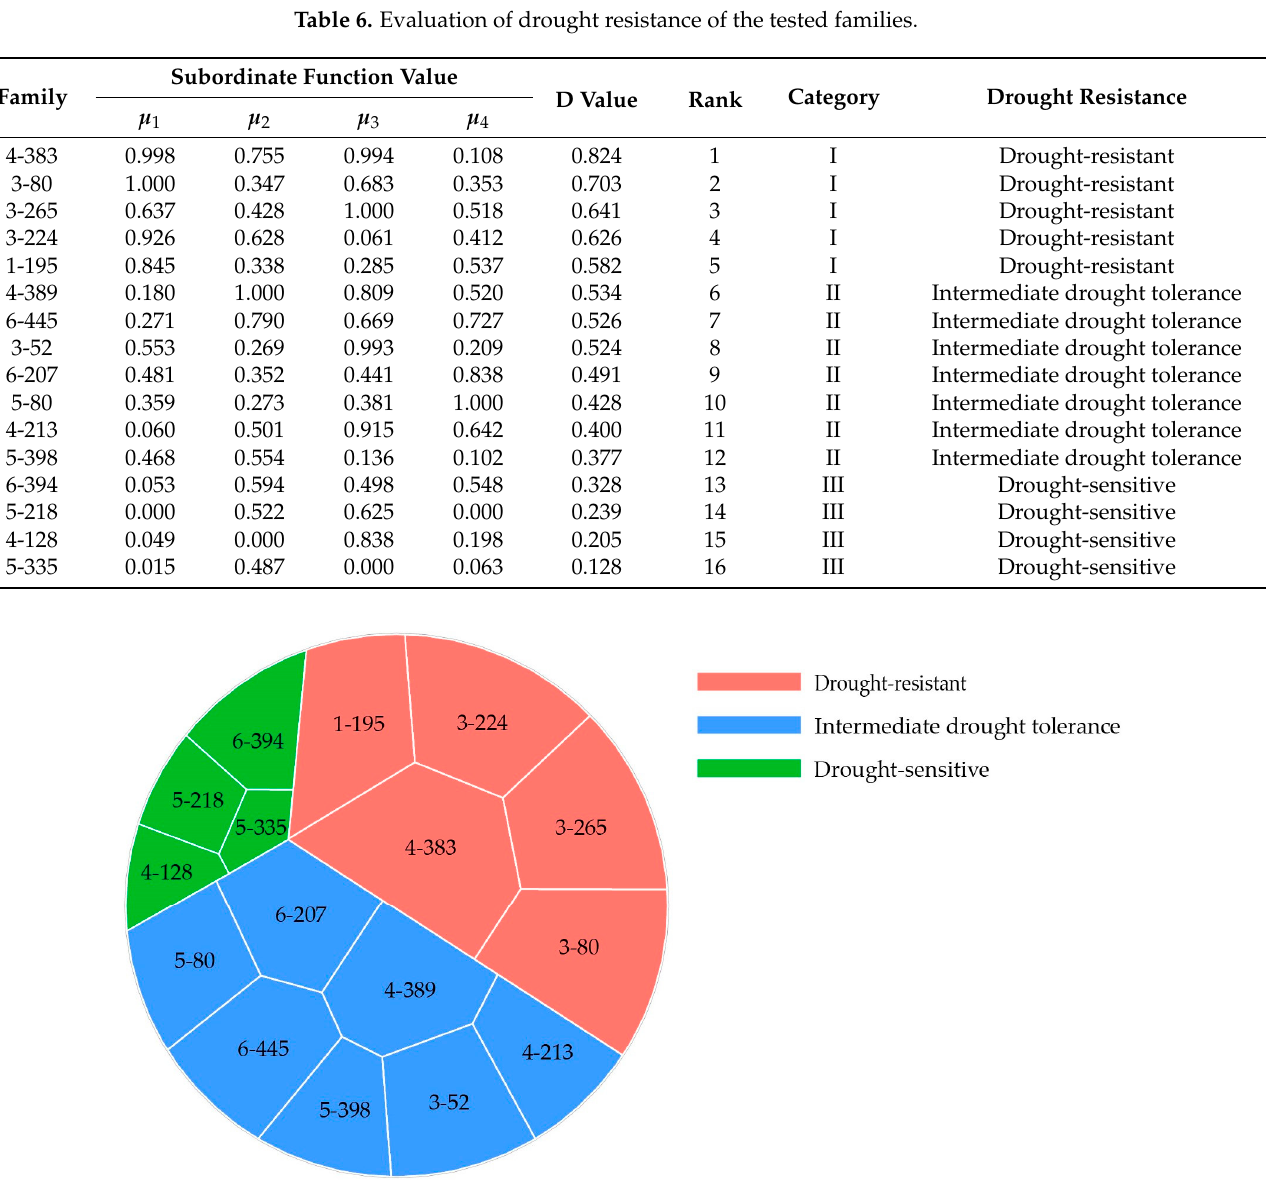
Figure 3. Preservation rate analysis among the tested families. ( a ): Histogram of preservation rate (%) for the tested families. ( b ): Analysis of the difference of preservation rate (%) of different drought resistant categories. Red represents drought-resistant families, blue indicates intermediate drought tolerance families, and green represents drought-sensitive families. The number indicates the